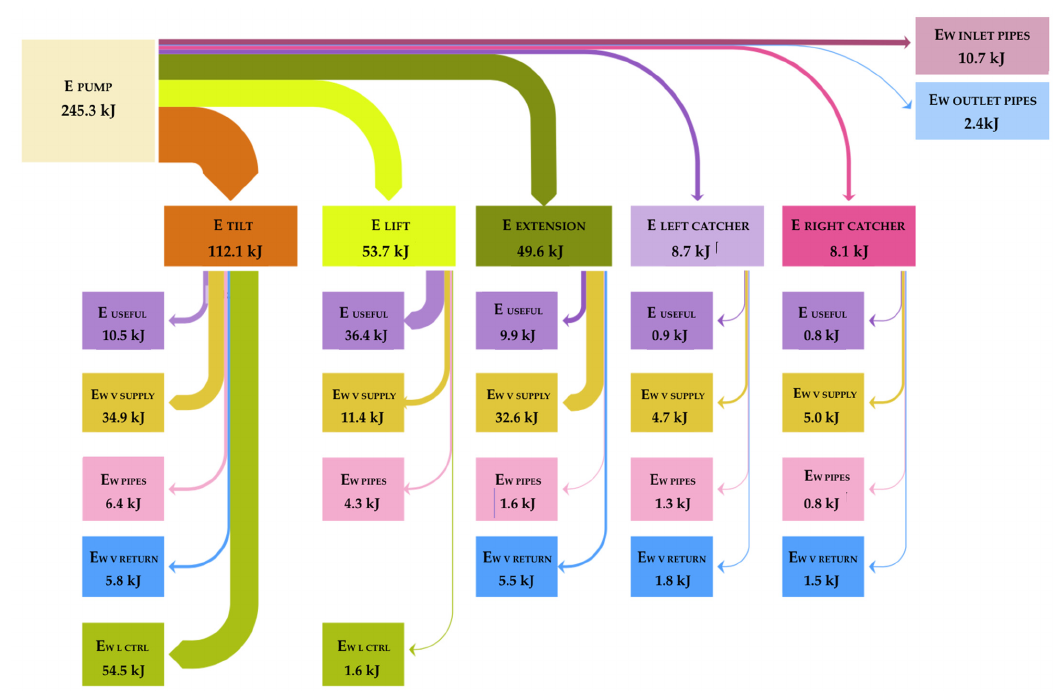
Figure 7. Sankey diagram for the 100 kg load condition.